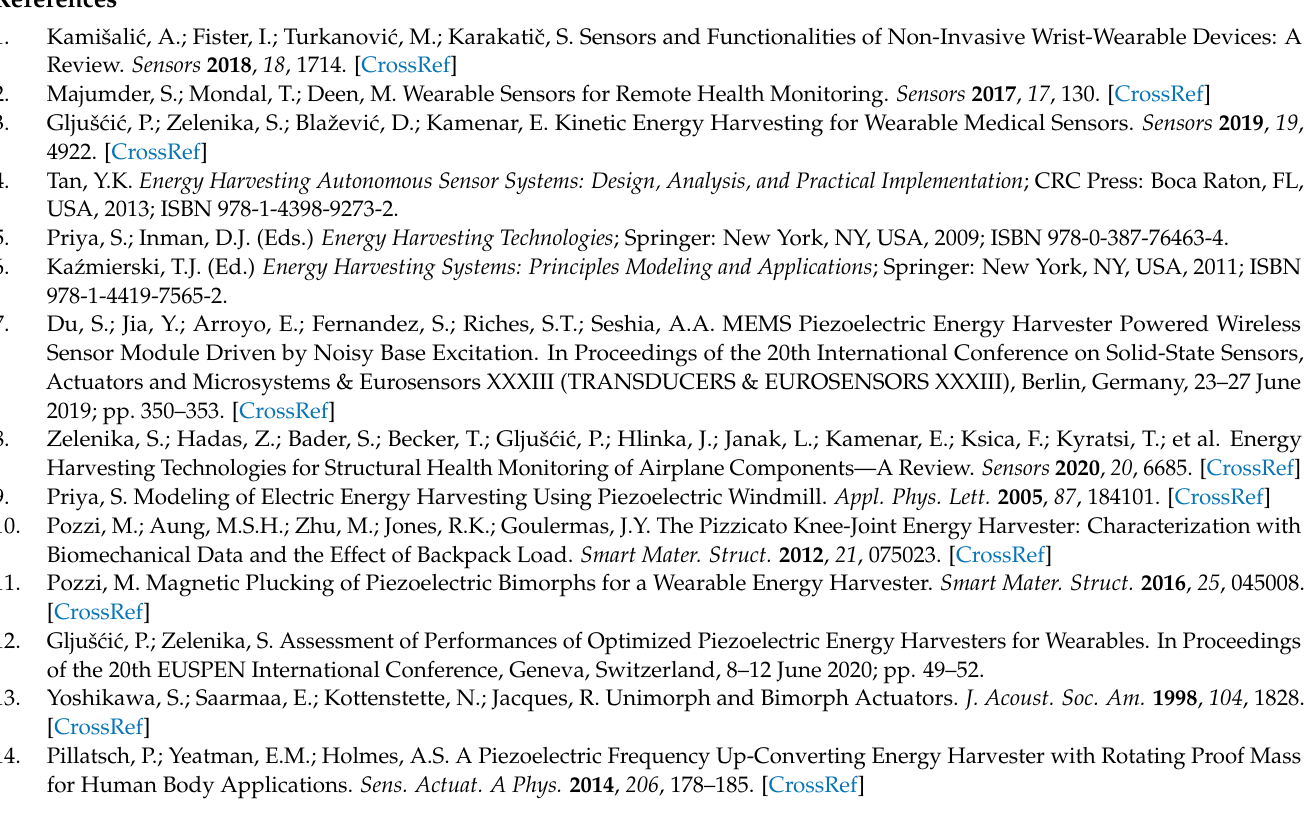
load, Figure 15, Figure 16, Figure 17, Figure 18 and Table 6: model_validation, Figure 19: EXP_voltage_ FUC, Table 7, Table 8 and Figure 20: